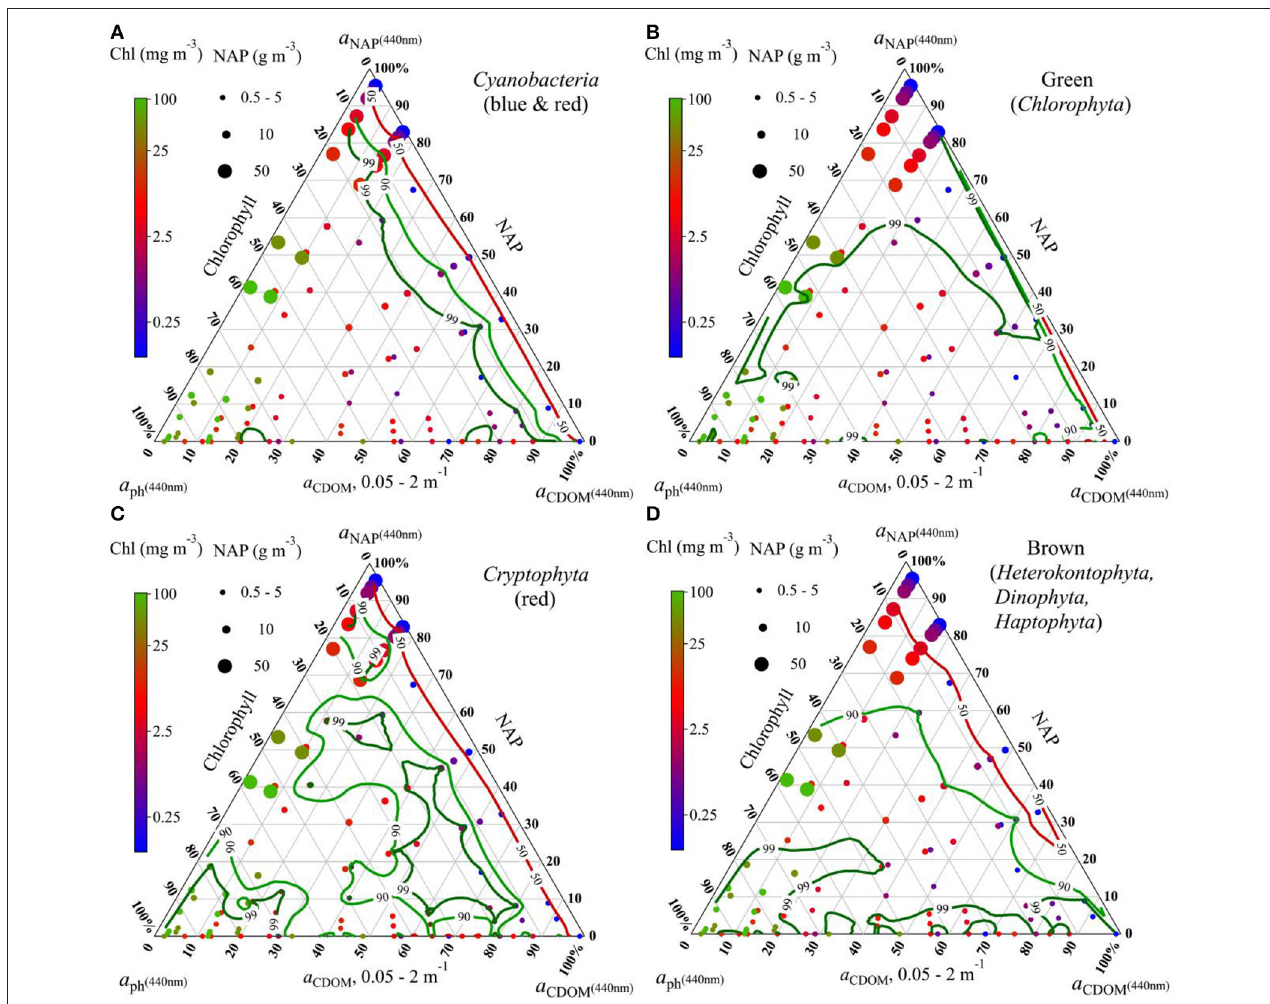
FIGURE 5 | Ternary plots showing the identification accuracy of phytoplankton groups (A) Cyanobacteria (red and blue), (B) Chlorophyta (green spectral group), (C) Cryptophyta (red), and (D) Brown spectral group in different water conditions with respect to fractions of phytoplankton, NAP, and CDOM absorption at 440 nm: Contour lines indicate the accuracy of identification. Colors of dots indicate Chl concentrations; sizes of dots indicate NAP concentrations. blue and red (combined in Figure 5A ) show a relatively distinct a NAP ∗ (440) = 0.0615 m 2 g − 1 as shown in Table 1 . Different contour pattern: the contour lines are roughly parallel with colors and sizes of the dots are used to represent the actual [Chl] low Chl contributions, e.g., the identification rate of 90% and [NAP] respectively, as the position in the ternary plot only shows each relative contribution. Contour lines of the identification accuracy are plotted for each spectral group ( Figure 5 ). The contour lines indicate different distribution of the identification accuracy for the different groups. However, a main finding in common is that low identification (50% contour line) for all groups located in the plot area where [NAP] is high (bigger dots) and [Chl] (blue dots) is low. However, this is not always true. If taking accuracy is also dependent on the absorption contribution of each